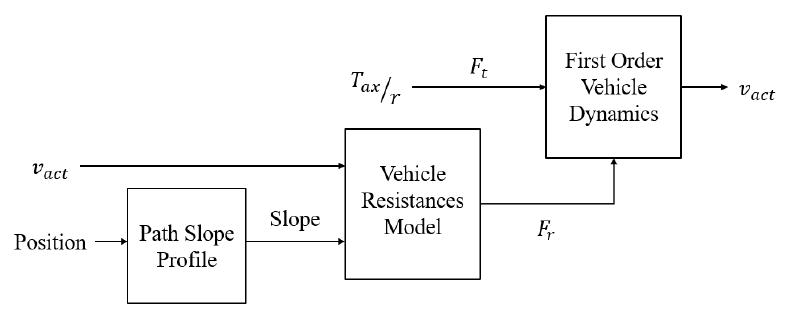
Figure 10. Block model structure of vehicle dynamics